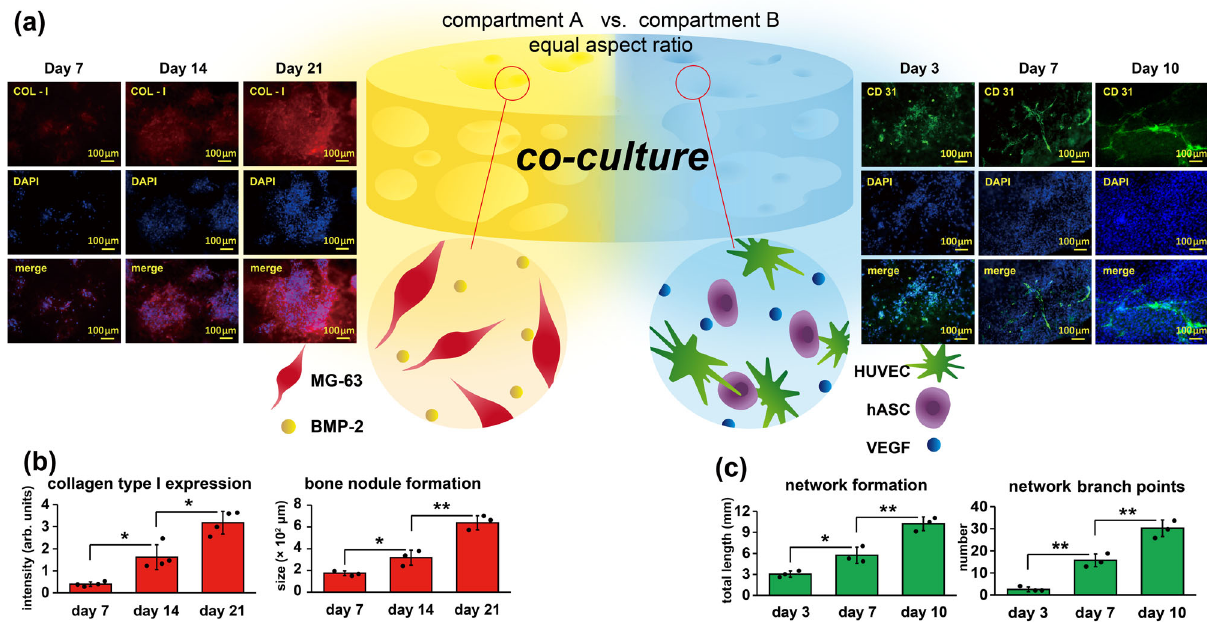
Fig. 4 Cell co-cultures of the modulated constructs with de fi ned and customized compartments of A containing the combination of MG-63 and BMP-2, and compartment B containing HUVECs, hASCs, and VEGF. The fabricated scaffold samples with the con fi guration of an equal aspect ratio for compartment A vs. compartment B was chosen in the study. a The recorded immuno fl uorescence images of fi brous type-I collagen (COL-I) expression at day 7, day 14, and day 21 indicated guided osteogenic activities in compartment A during the co-cultures. The bone-like nodules formed and increased in size over the indicated period. On the other hand, representative immuno fl uorescence images of platelet endothelial cell adhesion molecule (PECAM-1/ CD31) expression at day 3, day 7, and day 10 showed guided angiogenic activities in compartment B. The classic tube network formed and developed increasingly over the indicated period. b Quantitative analysis of osteogenic activities ( n = 4 or 3 independent samples; mean ± SD; unpaired t test; bottom left panel: day 7 vs. day 14 * p = 0.0217 < 0.05, day 14 vs. day 21 * p = 0.0249 < 0.05; bottom right panel: day 7 vs. day 14 * p = 0.0268 < 0.05, day 14 vs. day 21 ** p = 0.0043 < 0.01) and c angiogenic activities of the MG-63 and HUVEC co-culture samples containing compartmentalized BMP-2 and VEGF in compartment A and compartment B, respectively ( n = 3 independent samples; mean ± SD; unpaired t test; bottom left panel: day 3 vs. day 7 * p = 0.0202